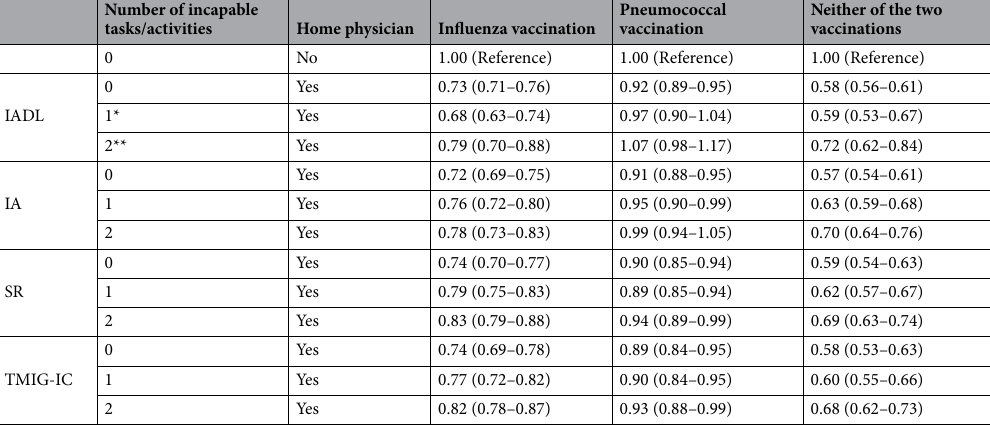
Table 3. IRRs and 95% CIs of interactions between IADL, IA, SR, or TMIG-IC and a family physician on non- receipt of vaccinations. IRR incident rate ratio, 95% CI 95% confidence interval, IADL instrumental activity of daily life, IA intellectual activity, SR social role, TMIG-IC Tokyo Metropolitan Institute of Gerontology Index of Competence. *Incapable of any one task/activity. **Incapable of any two tasks/activities. The IRRs and 95% CIs were adjusted for age, sex, marital status, educational attainment, equivalized income, household structure, smoking status, self-rated health, medical checkup, family physician, patient’s questioning attitude, high-risk disease, pneumococcal or influenza vaccination (only for non-receipt of influenza or pneumococcal vaccination), history of influenza or pneumonia, geriatric depression, homeboundness, civic participation, social cohesion, and